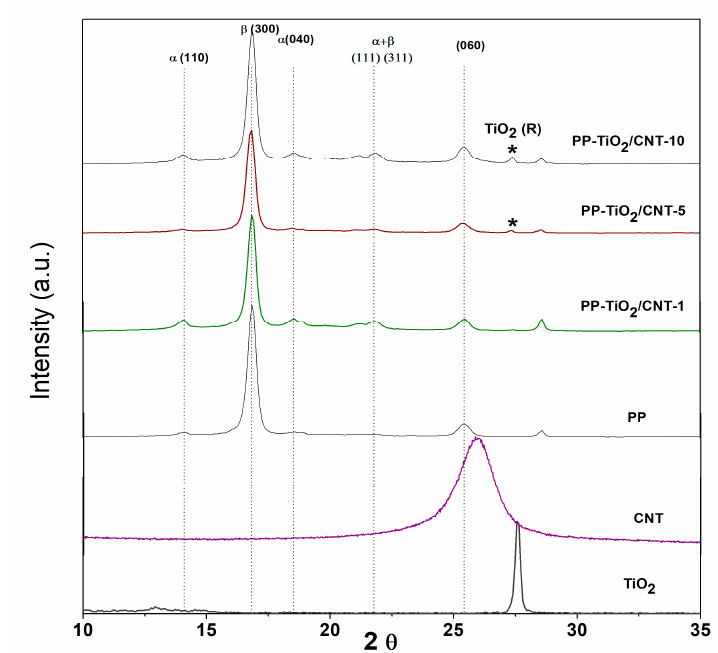
Figure 2. X-ray diffraction patterns of nanocomposite PP-TiO 2 /CNT (1,5,10%), polypropylene (PP), Figure 2. X-ray di ff raction patterns of nanocomposite PP-TiO 2 / CNT (1,5,10%), polypropylene (PP), carbon-nanotubes (CNT) and TiO 2 . carbon-nanotubes (CNT) and TiO 2